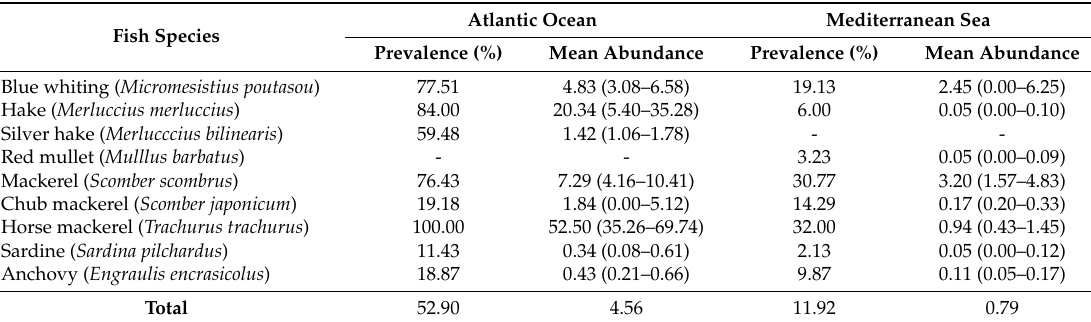
Table 2. Prevalence (%) and mean abundance and 95% confidence intervals of Anisakis type I larvae in the fish species analysed with respect to their geographic origin.